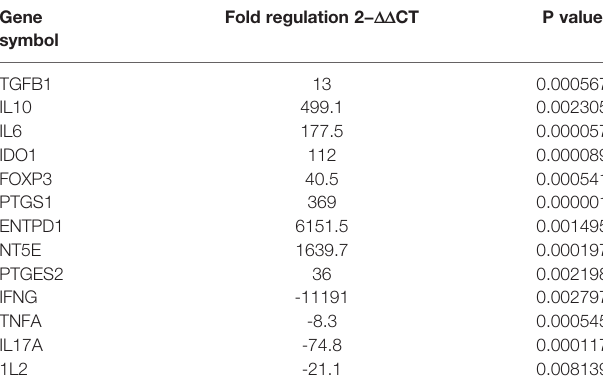
TABLE 5 | Upregulated and downregulated genes upon priming WJ-MSCs with TNF- a and IFN- g and cultured with activated T cells. Gene